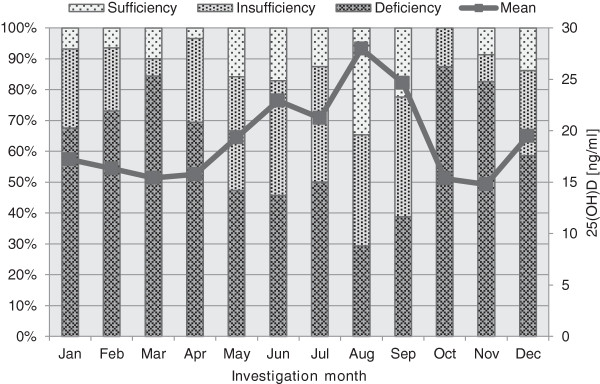
Seasonal variation of the prevalence of vitamin D deficiency and mean 25(OH) D values. The prevalence of vitamin D deficiency was higher in winter compared to the summer/autumn months. In August, only 29% were classified as vitamin D deficient, while in or after winter months, the prevalence reached more than 80% (March, 84%, October 87% and November 83%). 25(OH) D, 25-hydroxyvitamin D.